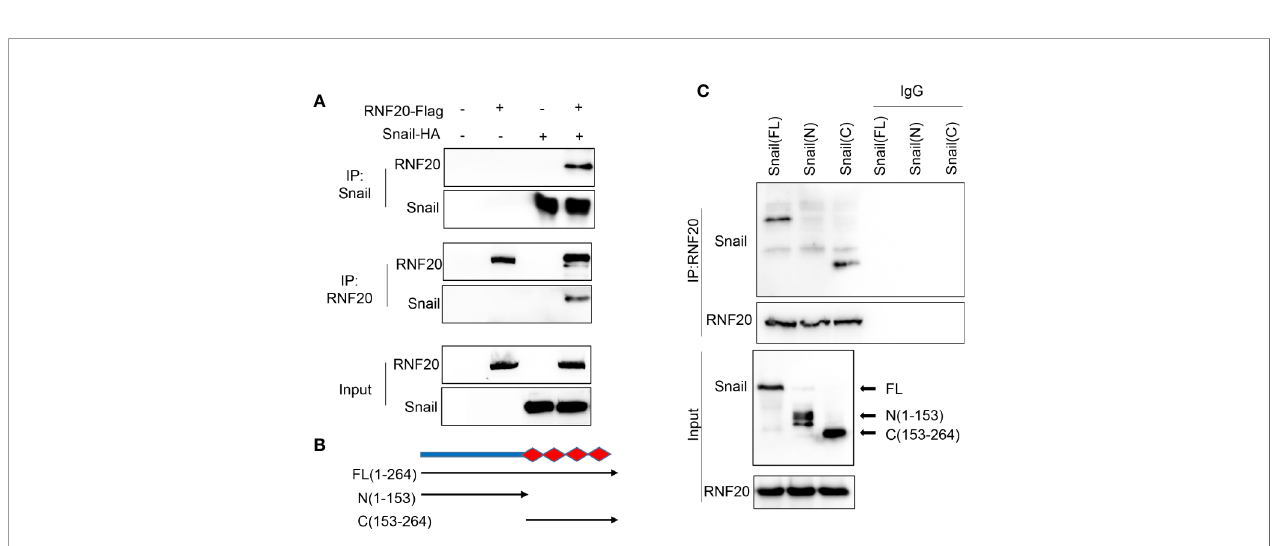
FIGURE 3 | RNF20 interacts with Snail. (A) 293T cells were transiently coexpressed with Flag-tagged RNF20 and HA-tagged Snail. Cell extracts were immunoprecipitated separately with Flag or HA antibodies, and the associated RNF20 and Snail were examined by Western blotting, respectively. (B) Schematic diagram showing the structure of Snail and two deletion mutations. (C) Full-length and deletion mutants of Snail were coexpressed with RNF20 in 293T cells. After immunoprecipitation of RN20, associated Snail was analyzed by Western blotting.